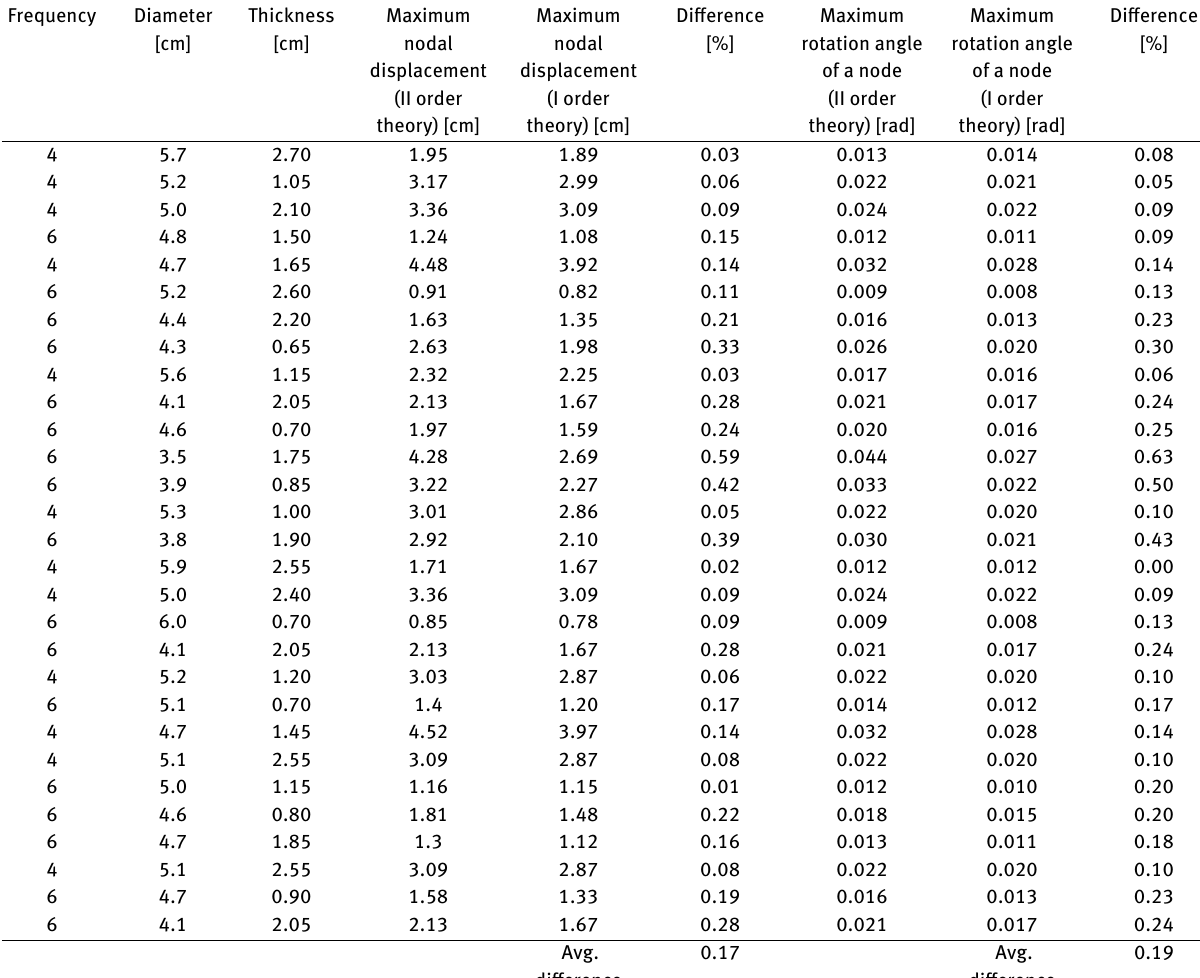
Table 7: Maximum nodal displacement for different dimensions of the dome